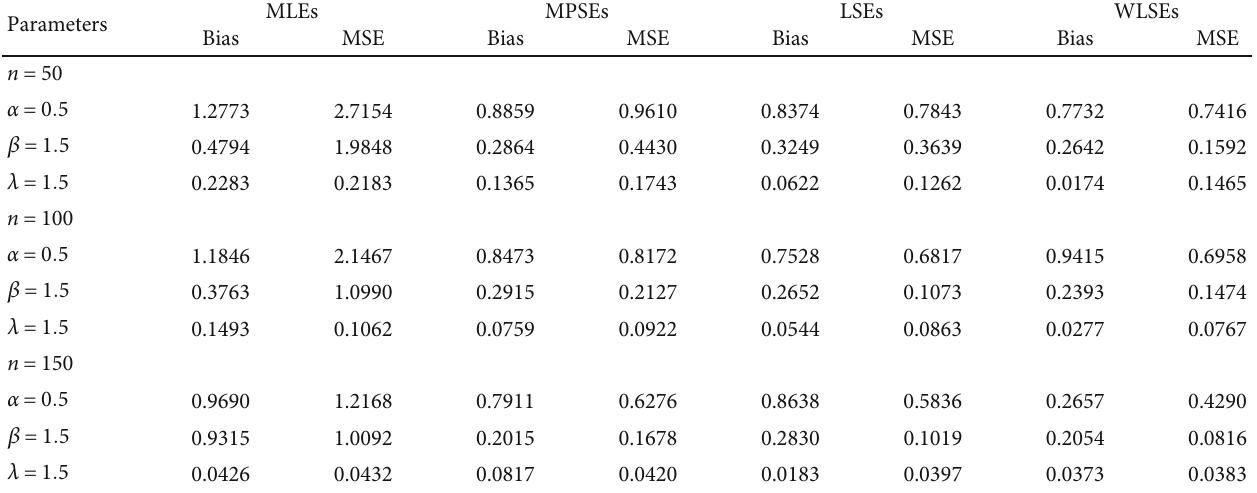
Table 3: Bias and MSE values for α , β , and λ of the XGAIW distribution.